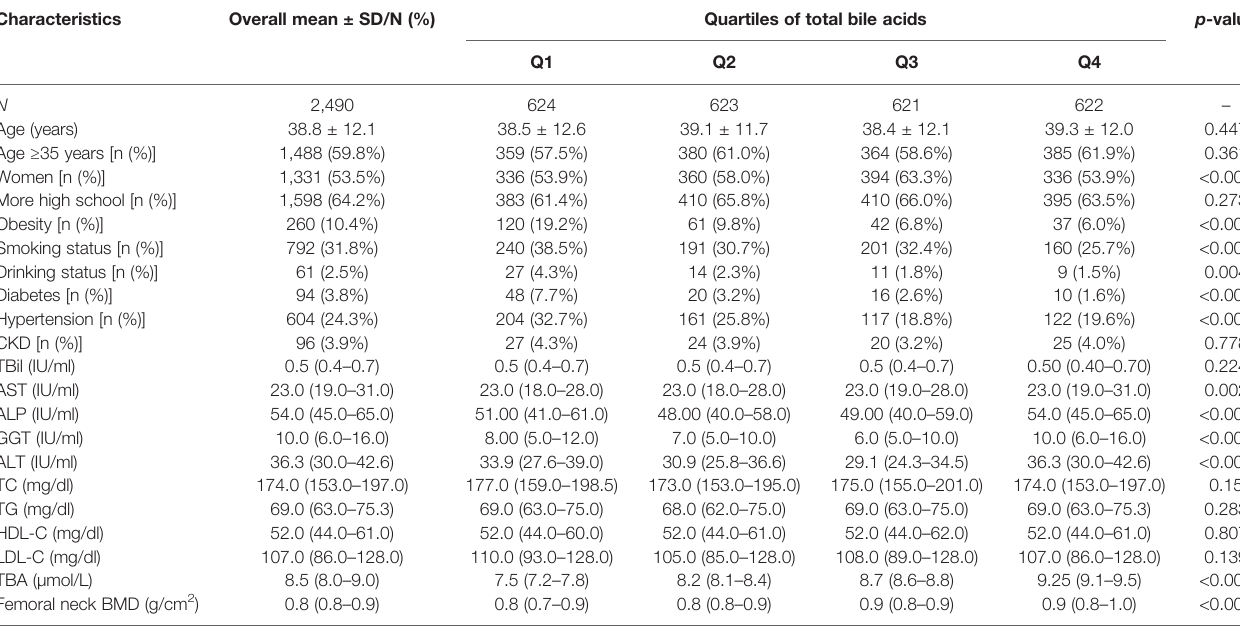
TABLE 1 | Clinical characteristics of the participants according to quartiles of TBA. Characteristics